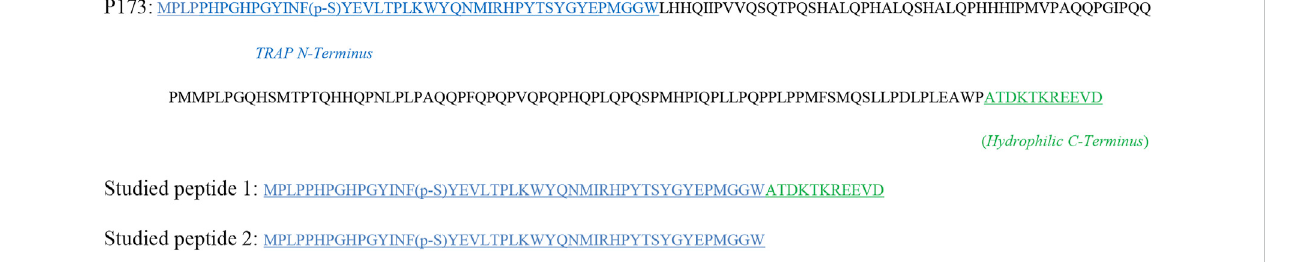
FIGURE 1 Full-length amelogenin P173 and synthesized peptide ’ s amino acid composition.